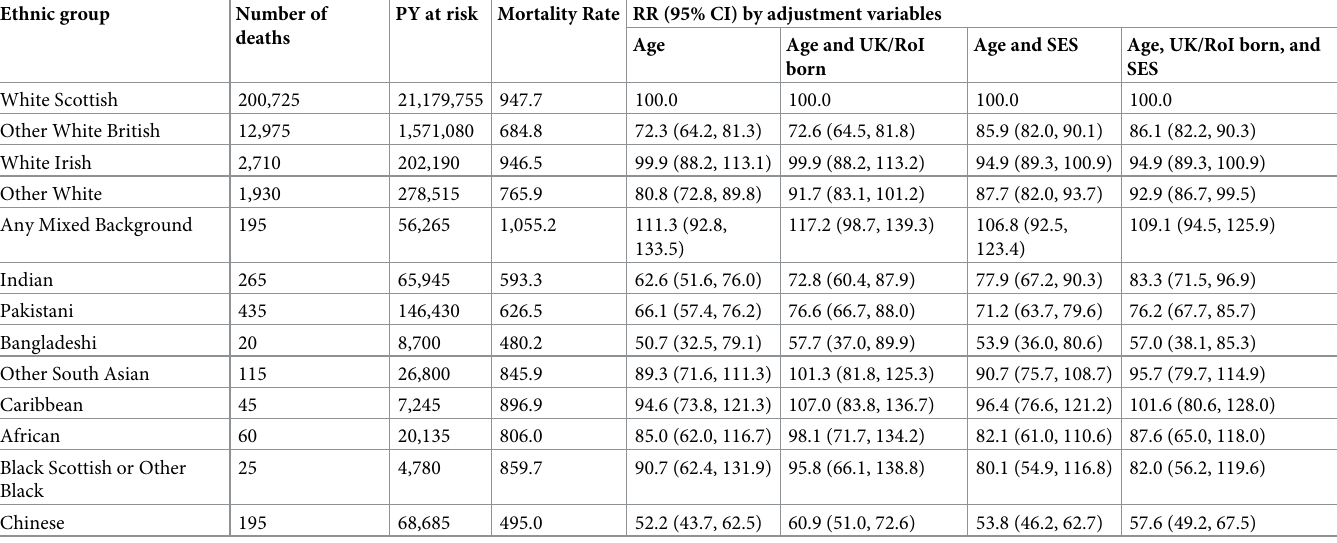
Table 1. Age-adjusted mortality rates per 100,000 PY and RRs for all-cause mortality by ethnic group in males.